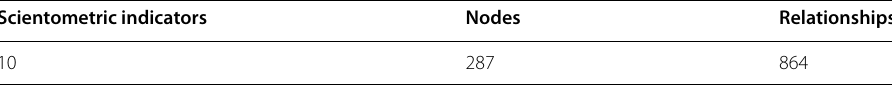
Table 8 Neo4j graph database